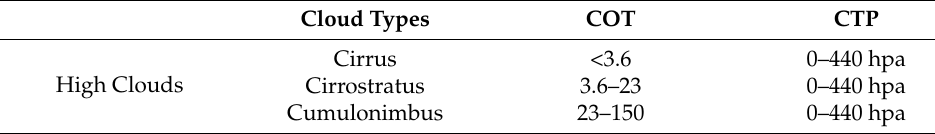
Table 2. ISCCP cloud classification for high cloud